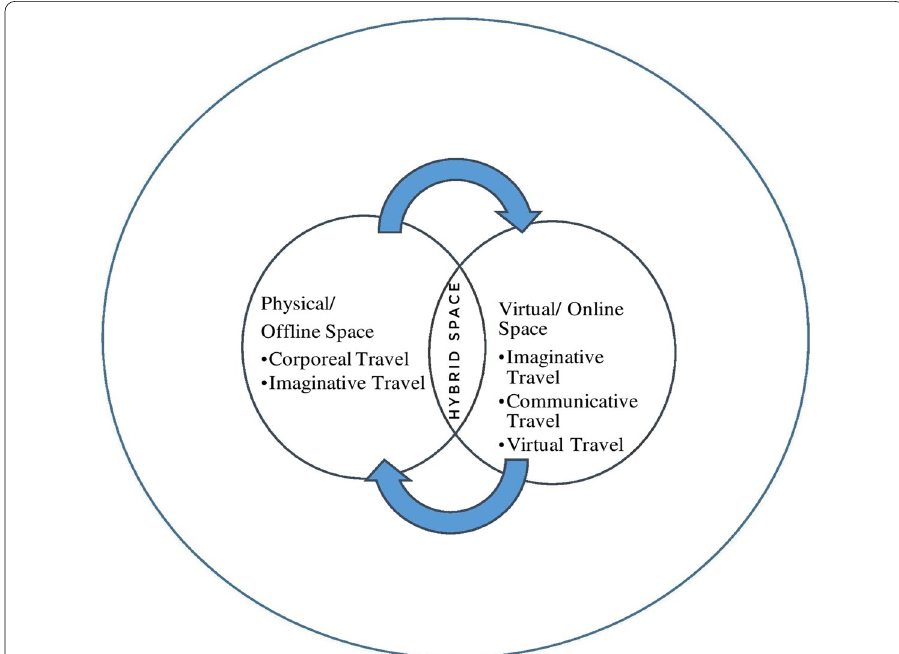
Fig. 4 Hybrid learning space as a blended and inclusive